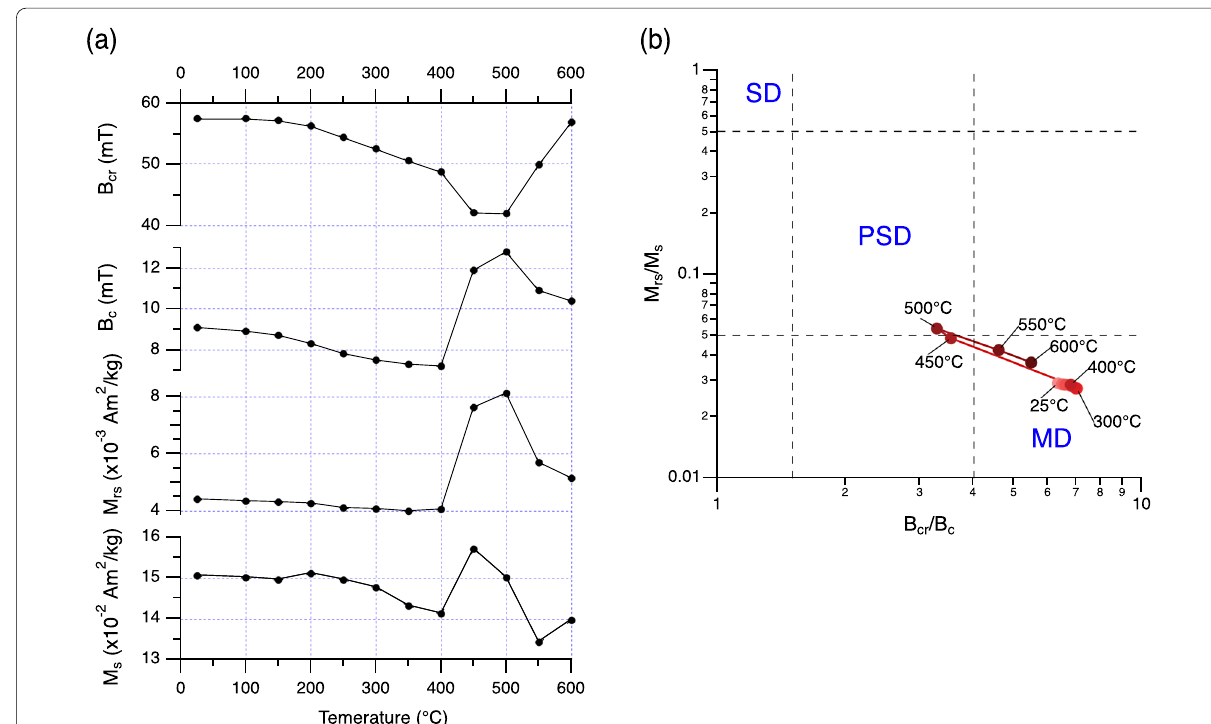
Fig. 11 Change of hysteresis parameters during heating. a Hysteresis parameters during heating in air of sample 102-1Z-3. b Day plot for the hysteresis parameters during